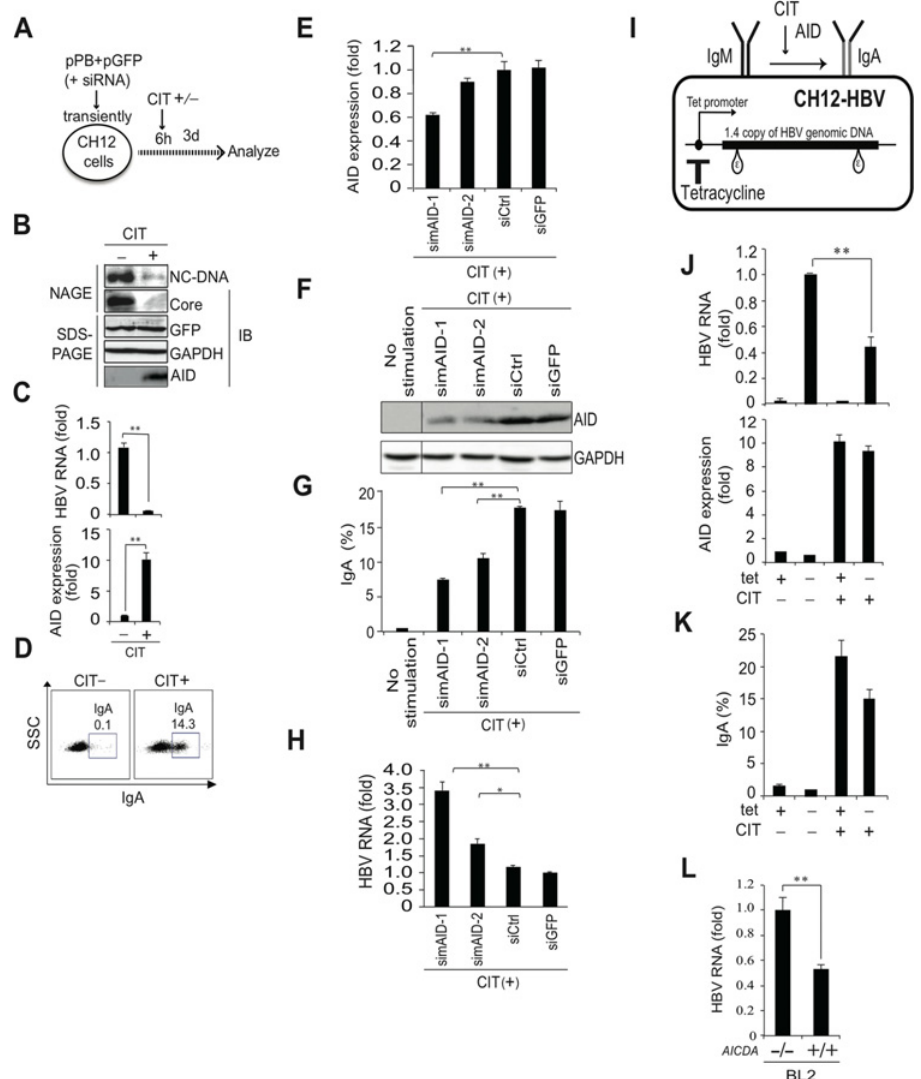
Fig 3. IgA switching activity correlates with reduction of HBV transcripts in B cells. (A, B, C, D) pPB and GFP expression vectors were transiently co-transfected into a mouse B cell line (CH12F3-2). Six hours after transfection, cells were divided into two groups and stimulated with (or without) CD40 ligand, IL-4, and TGF- β 1 (CIT) for 3 days to induce IgA switching; (A) Schematic diagram of experimental design; (B) Nucleocapsid formation was measured using NAGE assays and GFP expression was used to confirm transfection. (C) HBV transcripts and AID expression levels were determined using qRT-PCR. (D) AID dependent IgA switching was determined using flow cytometry. (E, F, G, H) CH12F3-2 cells were co- transfected with pPB and the indicated siRNA against mouse AID (simAID-1 and -2) or controls (siCtrl and siGFP), and after 6 hours incubation, cells were further stimulated with CIT for 3 days. HBV transcript levels, knock down efficiency of AID, and IgA switching were determined using qRT-PCR, western blotting, and flow cytometry, respectively. (I, J, K) A tetracycline promoter-regulating HBV plasmid (pTre-HBV) was stably transfected into CH12F3-2 transfectants expressing tetracycline-responsible transactivator (Tet-off). Established CH12F3-2 transfectants were designated CH12-HBV; (I) Schematic diagram of CH12-HBV; (J) CH12-HBV cells were incubated in the presence or absence of CD40 ligand, IL-4, or TGF- β 1 (CIT) and tetracycline as indicated for 2 days to induce endogenous AID expression and IgA switching. HBV transcription and AID expression levels were determined using qRT-PCR. (K) IgA switching was detected according to surface expression of IgA using flow cytometry. (L) AICDA-deficient and-wild type BL2 cells were transfected with HBV plasmid (pPB), and qRT-PCR was performed at 3 day post-transfection. * P < 0.05, ** P < 0.01 ( t -test). Data are representative of two to three independent experiments and error bars represent standard errors of the